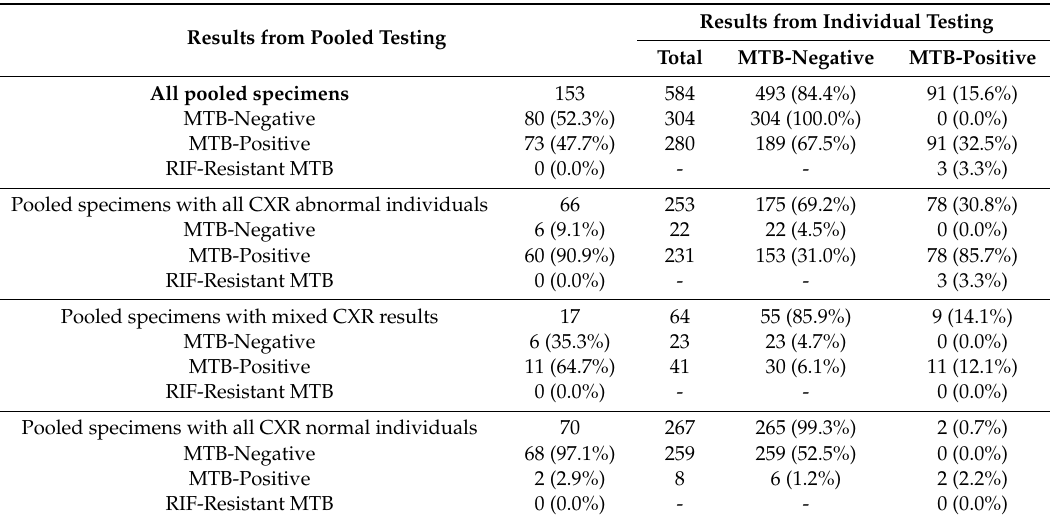
Table 3. Pooled and individual results